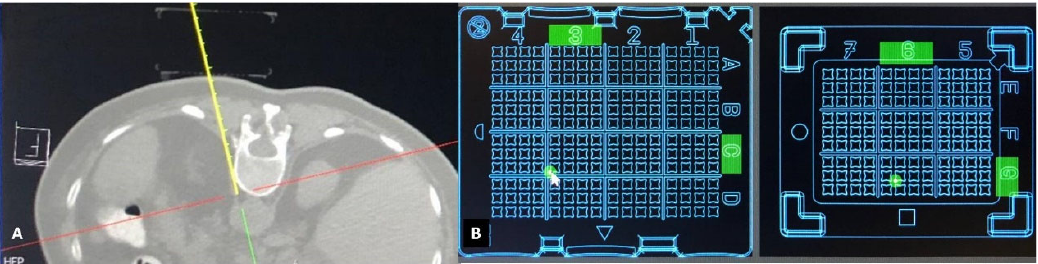
Figure 3. Planning of the puncture: ( A ): The yellow line represents the planned puncture path via a virtual needle (markers on the line represent cm). ( B ): The software calculates the entry (upper plate left) and exit point (lower plate right) and displays green dots at the coordinates to be used for this particular planned line.